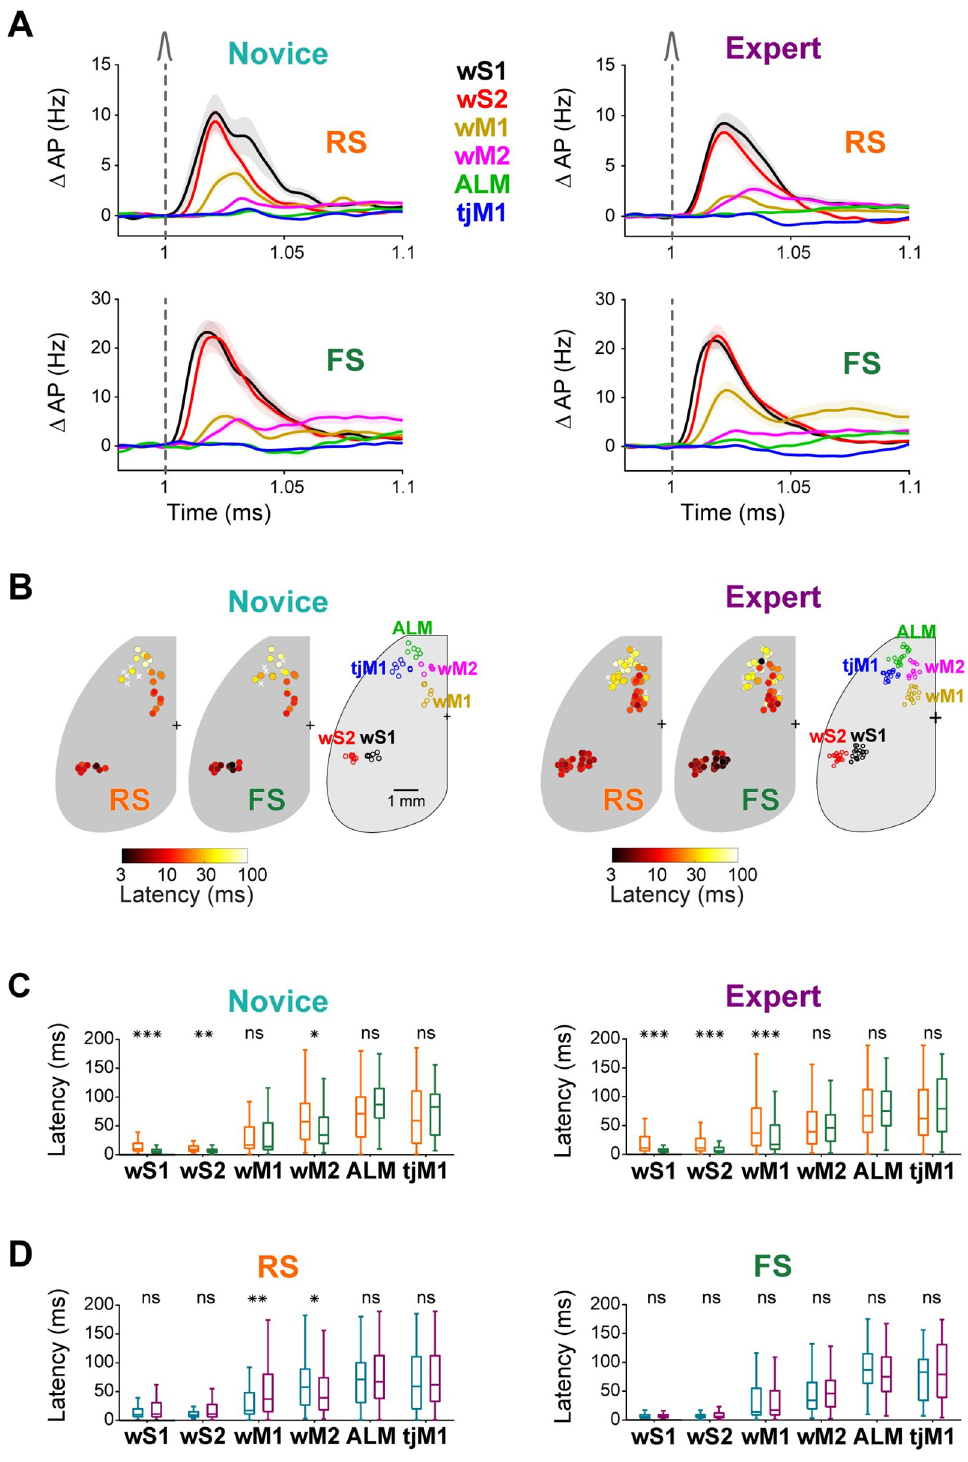
Fig 3. Fast propagation of sensory responses across cell classes and cortical regions. (A) Change in firing rate (mean ± SEM) of different cortical regions in the first 100-ms window after whisker deflection for RS (top) and FS (bottom) neurons in Novice (left) and Expert (right) mice (numbers of units and mice are the same as in Fig 2). (B) Whisker-evoked response latency maps. For each silicon probe in Novice (left) and Expert (right) mice, average latency of whisker-evoked response is shown separately for RS and FS units. Circles represent silicon probes and are